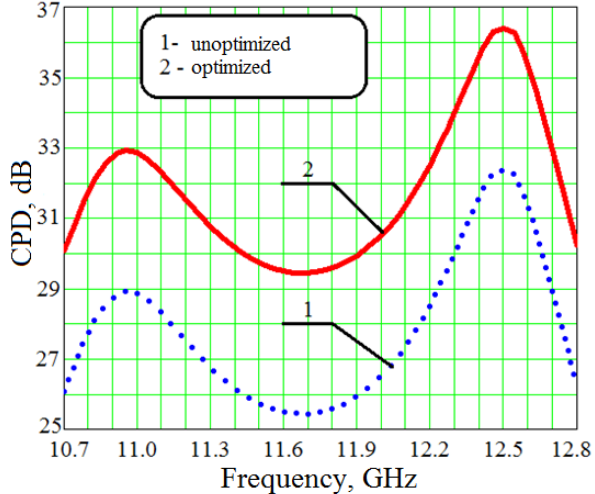
FIGURE 5. Ellipticity coefficient vs. frequency for the square waveguide polarizer with three diaphragms